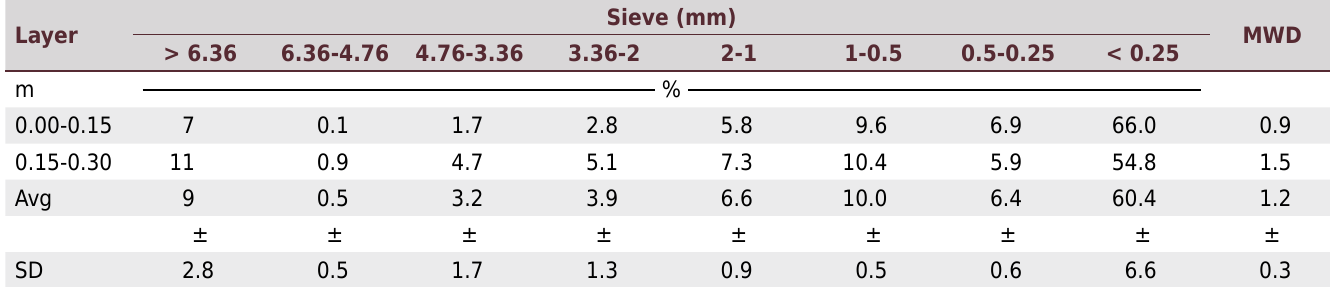
Table 3. Distribution of aggregates and mean weight diameter of soil samples from La Comarca Lagunera, Mexico Layer